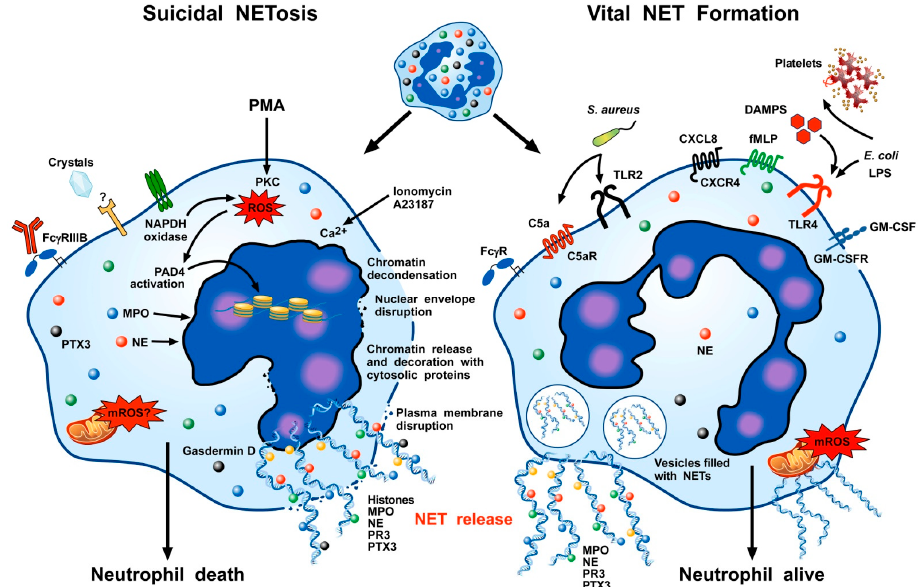
Figure 2. The most potent inducer of NETosis in vitro is phorbol 12-myristate 13-acetate (PMA), which activates protein kinase C (PKC) in human neutrophils. [15]. Several other stimuli such as agonists of Fc γ RIIIB [86], crystals [86,87], and the Ca 2+ ionophore A23187 or ionomycin [88] can induce suicidal NETosis. NET formation induced by PMA requires NADPH (nicotinamide adenine dinucleotide phosphate) oxidase activity, but the requirement for this enzymatic activity differs de- pending on the stimulus [89]. Neutrophil elastase (NE) translocates from the cytoplasmic granules to the nucleus and activates its proteolytic activity in a myeloperoxidase (MPO)-dependent manner [90]. In the nucleus, NE degrades specific histones promoting chromatin decondensation [68]. Pep- tidyl arginine deiminase 4 (PAD4), which converts arginine residues into citrulline [91], catalyzes histone citrullination [69]. This results in a loss of positive charges on arginine residues in histones, which loosen the forces between DNA and histones and contributes to chromatin decondensation [92]. After nuclear envelope disruption, the chromatin comes into contact with several cytoplasmic granules (e.g., NE, MPO, PR3 (proteinase 3), PTX3 (pentraxin 3)) [12]. The rupture of the plasma membrane and the consequent NET release are mediated by gasdermin D [78,93,94]. In vital NET formation, the cell remains intact and normal cellular functions of neutrophils, such as chemotaxis and phagocytosis, can still be carried out [18,72,73,80,95]. This process is biochemically distinct from suicidal NETosis. A variety of stimuli such as bacterial products [73,95], GM-CSF and C5a [72,96], immune complexes [81,96,97], lipopolysaccharide (LPS) [80,98,99], and conditioned media of cancer cells [18] can rapidly (within 30 min) induce vital NET formation. Vital NET formation occurs with- out nuclear membrane disruption and has been reported with DNA leaving the cytoplasm in vesi- cles [73,80,95]. DNA becomes decorated with granule proteins (e.g., NE, MPO, PR3)[72,96]. Mito- chondria can mediate mitochondrial ROS (mROS) formation [18,97]. (DAMP (damage-associated molecular pattern); E. coli, Escherichia coli; S. aureus, Staphylococcus aureus